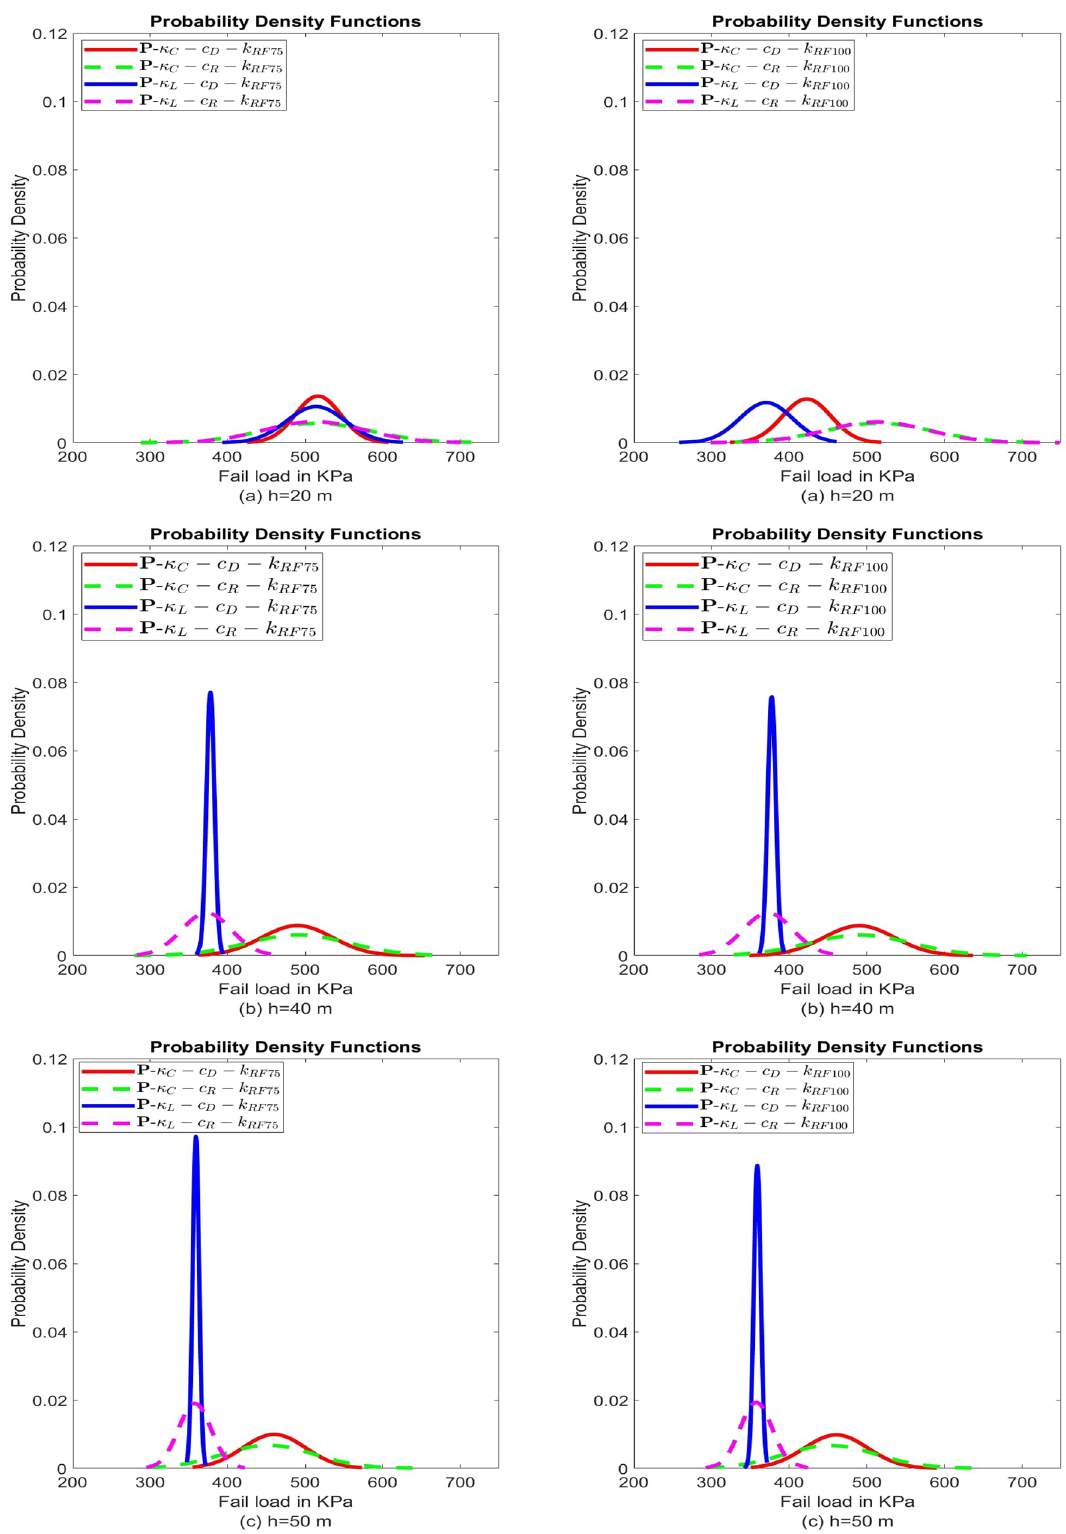
Fig. 9 PDFs of failure load of porous analyses with linear and constant distribution for